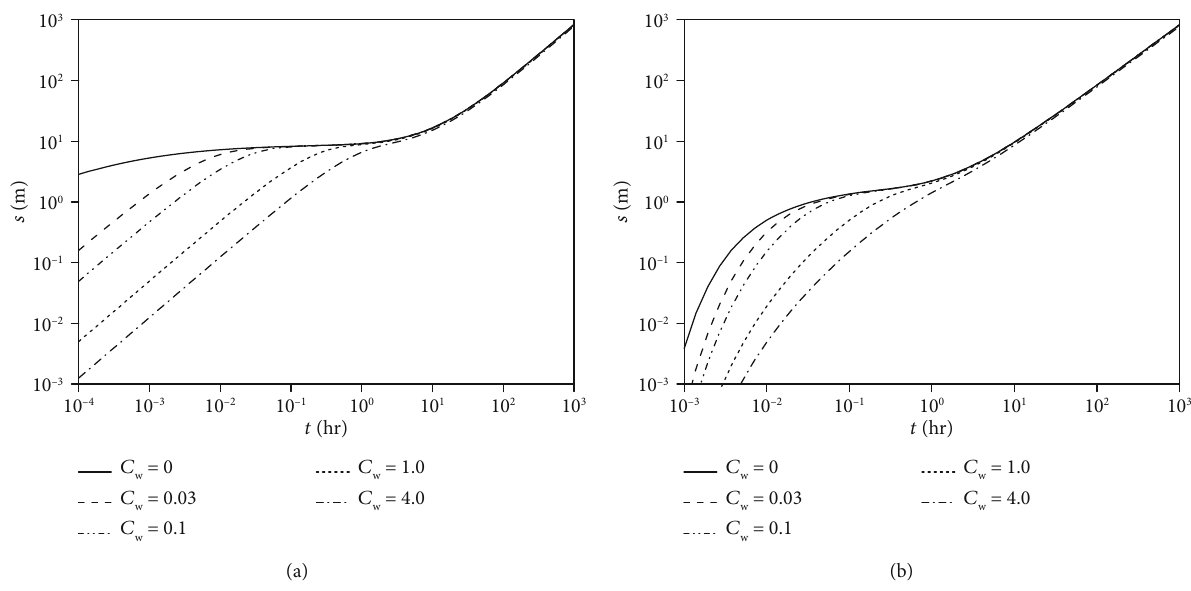
Figure 6: Impact of wellbore storage on the drawdown in pumping well (a) and aquifer (b).